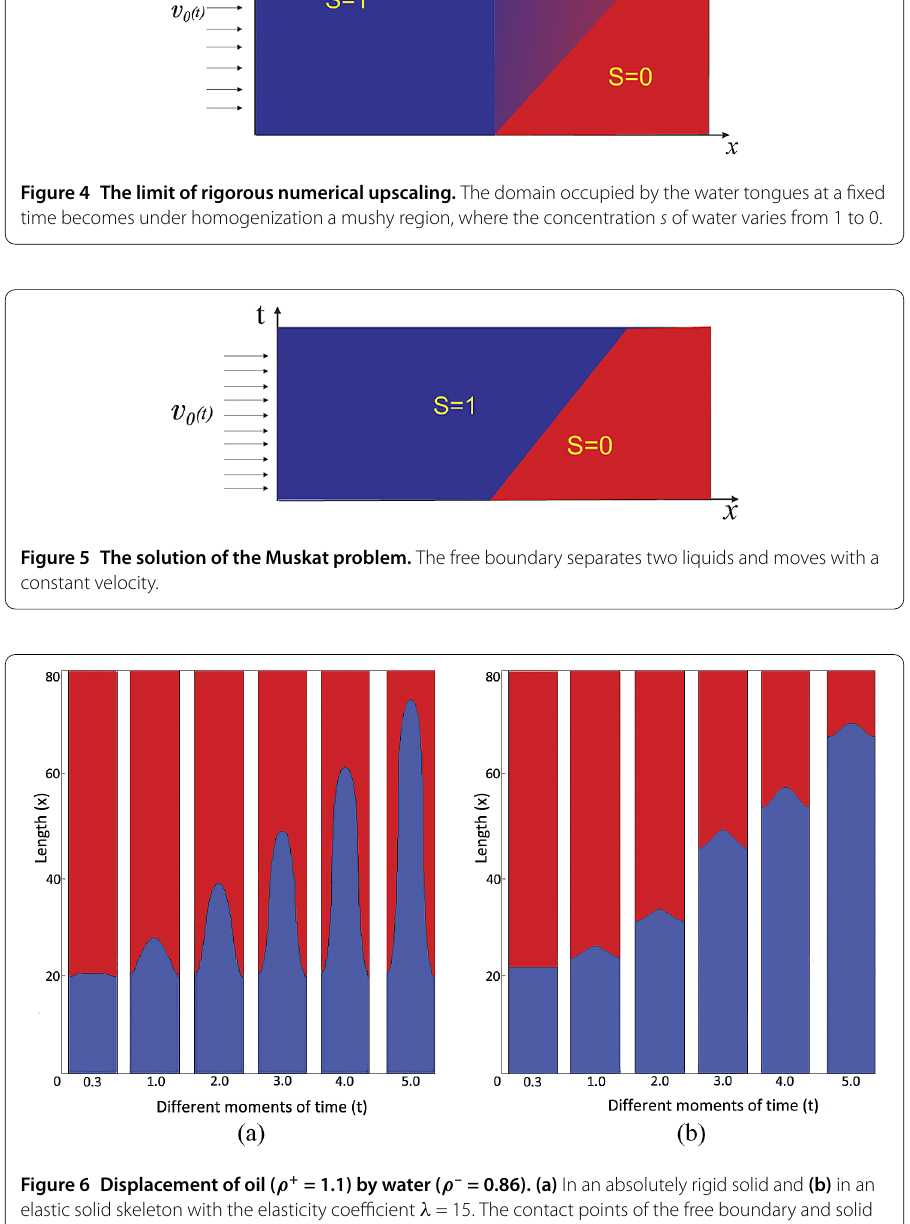
free boundary and solid body begin to move (Figure ), and homogenization conserves the free boundary which separates the two